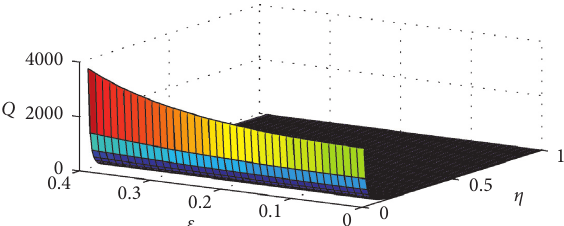
Figure 16: A plot of Mandel’s Q -factor (equation (39)) versus ε and � 0 . 15. A for η � 0 . 1, κ � 0 . 8, and n th